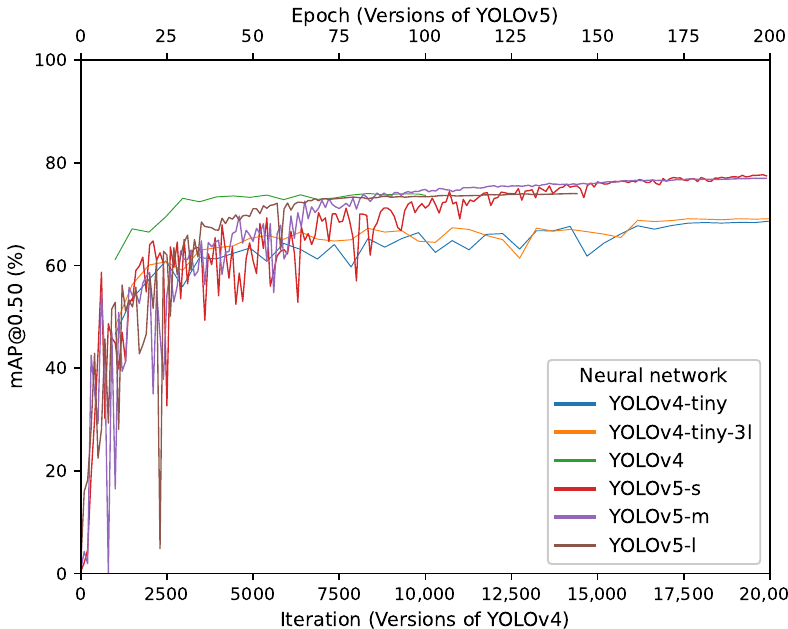
Figure 8. mAP@0.50 calculated for the test set during training of the CNN algorithms with a confidence of